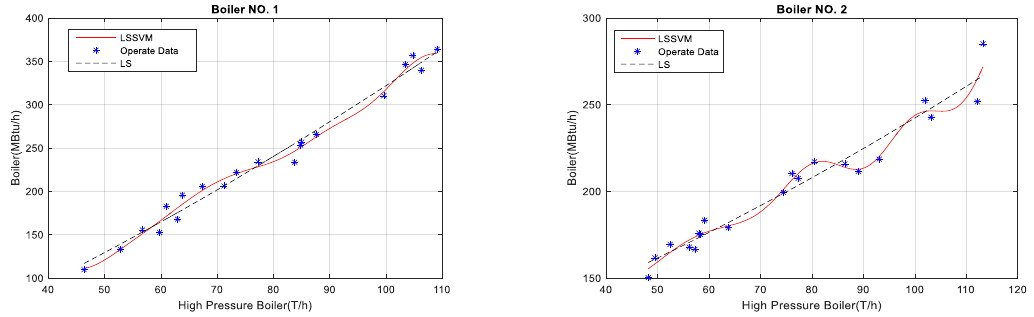
Figure 5. Example of the operation models of boilers 1–2.